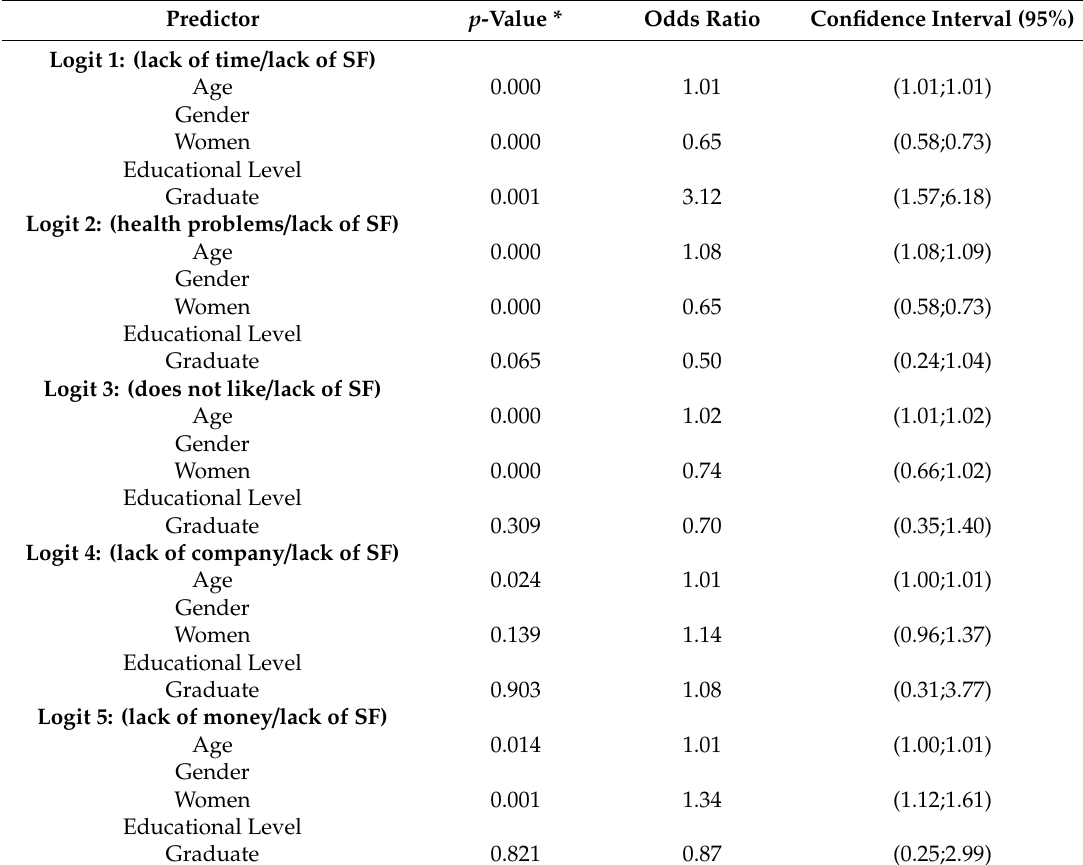
Table 3. Main results of the nominal logistical regression—motives for not practicing